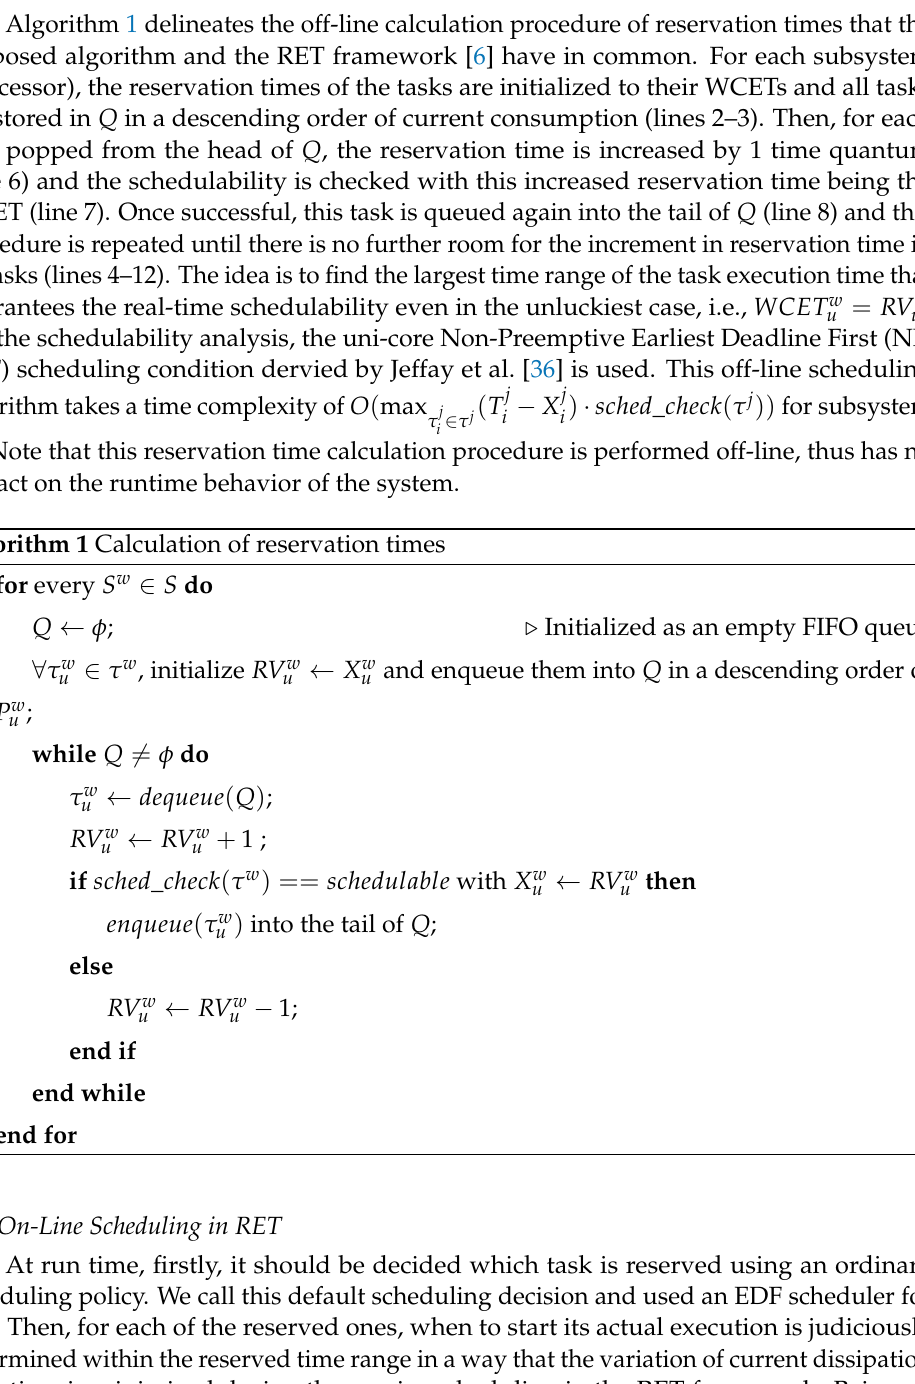
Algorithm 1 delineates the off-line calculation procedure of reservation times that the